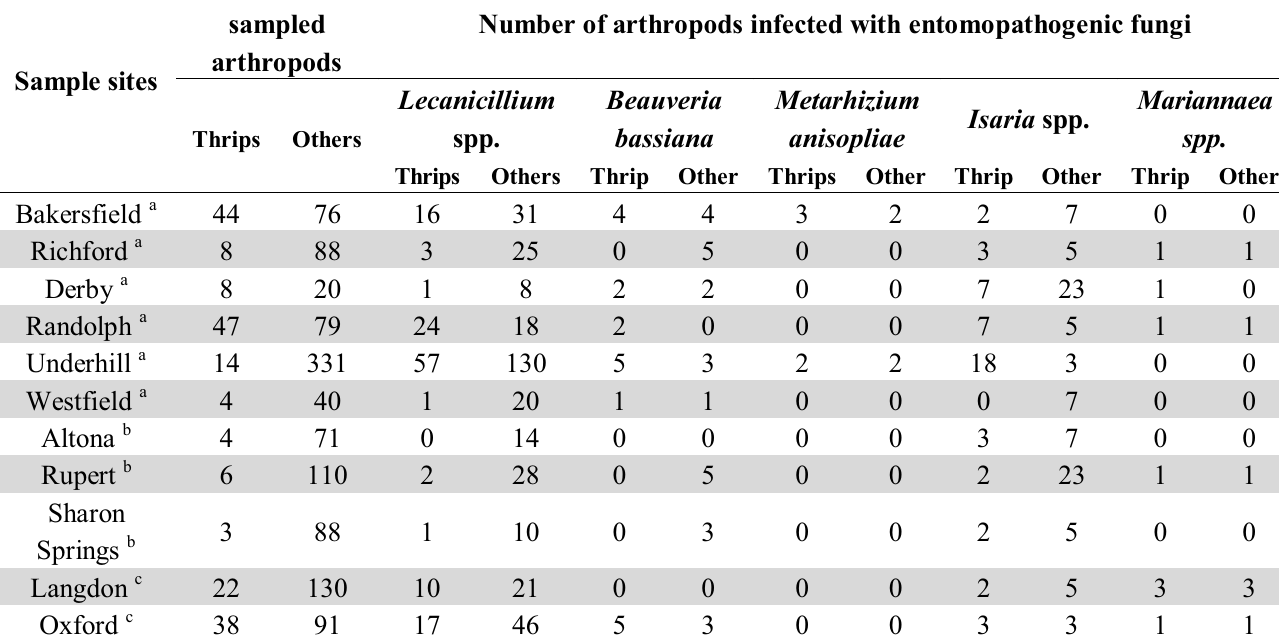
Table 2. Entomopathogenic and entomophilous fungi isolated from pear thrips and associated soil arthropods (mites, collembolans and fungus gnats) on forest soil during the period of August (cid:177) October